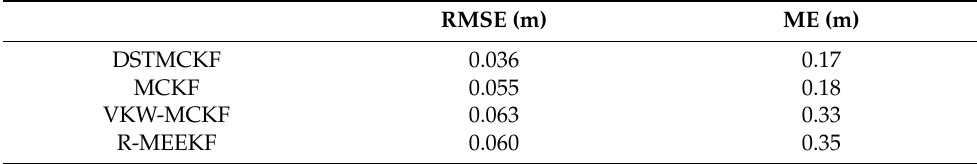
Table 6. RMSE and maximum error of three